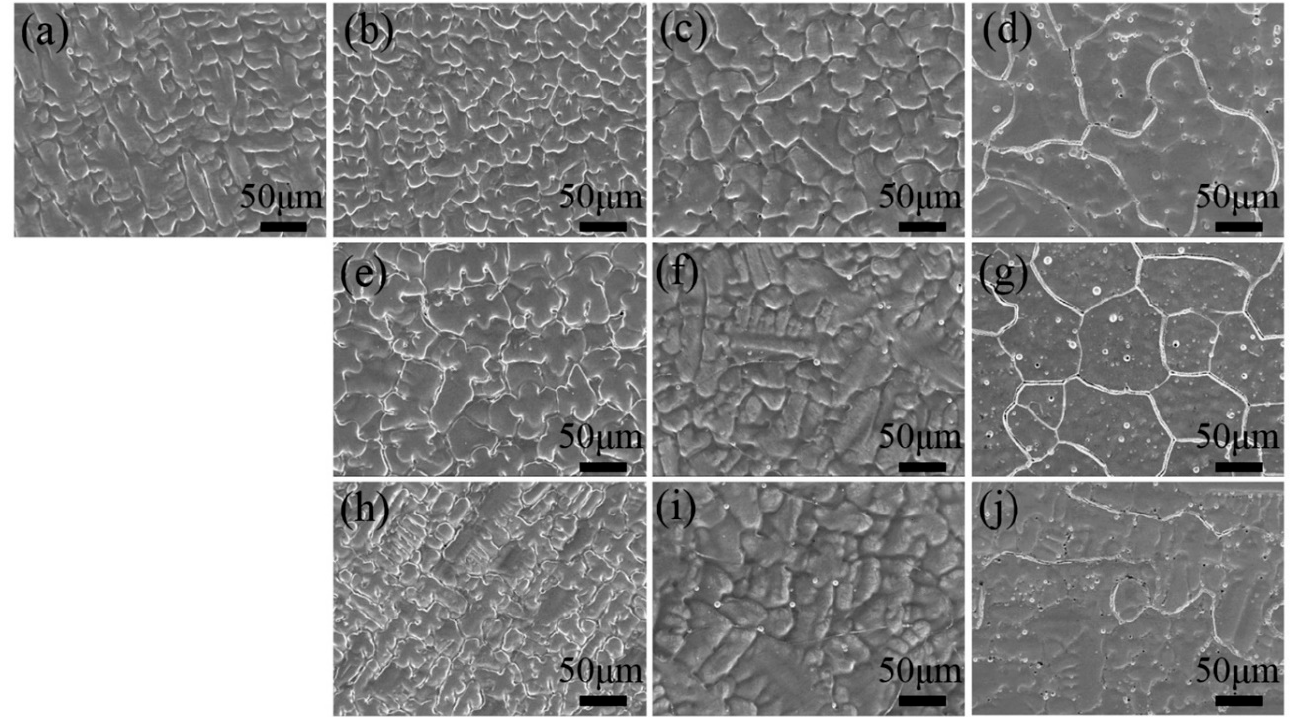
Figure 1. SEM images of the as-cast CoCrW-xNi-yCu alloys: ( a ) CoCrW, ( b ) CoCrW-1Cu, ( c ) CoCrW-2Cu, ( d ) CoCrW-4Cu, ( e ) CoCrW-3Ni-1Cu, ( f ) CoCrW-3Ni-2Cu, ( g ) CoCrW-3Ni-4Cu, ( h ) CoCrW-5Ni-1Cu, ( i ) CoCrW-5Ni-2Cu, and ( j ) CoCrW-5Ni-4Cu alloys.